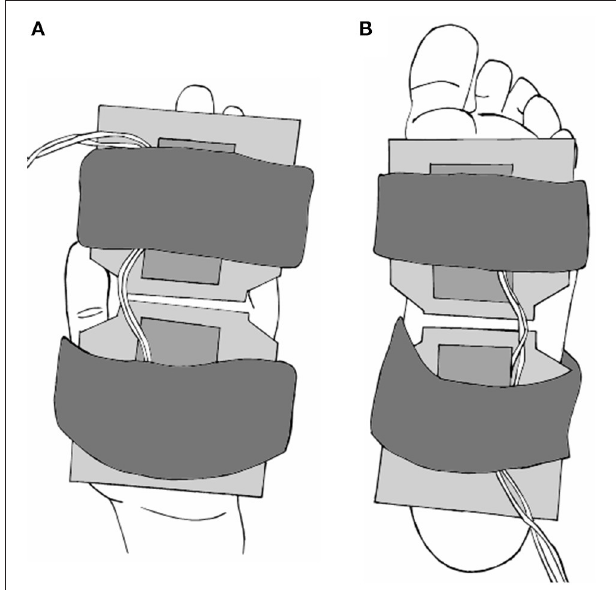
FIGURE 1 | Diagram of the vibration pads on the palm of hand (A) and foot sole (B) . Two 7.5 cm by 7.5 cm pads were secured to each location with elastic straps, and positioned to maximize skin contact. Pads produced a mechanical vibration of 150Hz, 220 µ m peak-to-peak amplitude.